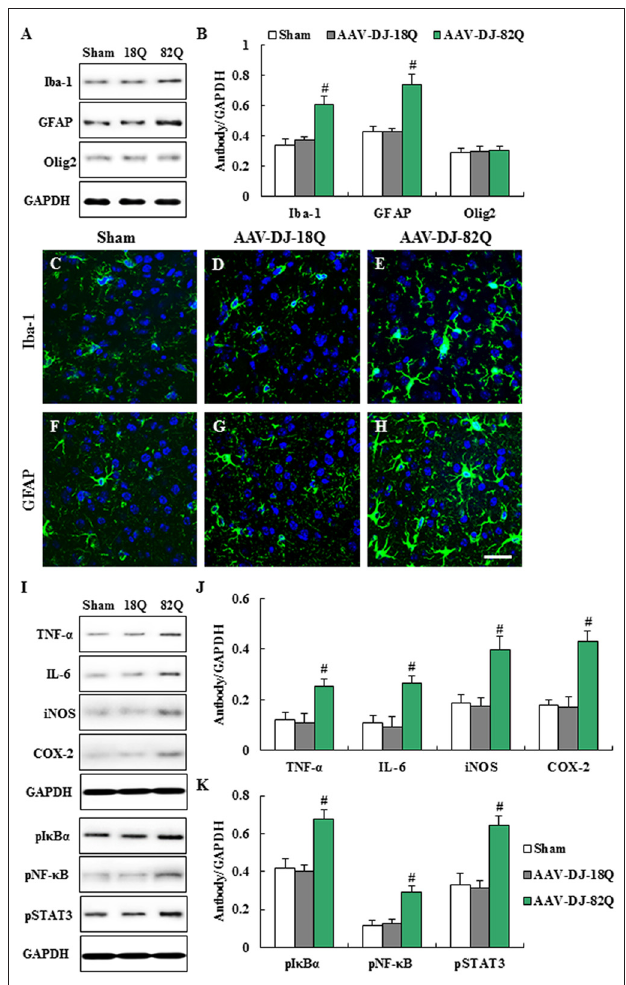
FIGURE 3 | AAV-DJ-82Q-infection induces microglial and astroglial activation and 263–270 inflammation in the striatum. (A–F) Eight weeks after the AAV-DJ-82Q-injection, the striata from sham, AAV-DJ-18Q, and AAV-DJ-/82Q groups ( n = 7 per group) were analyzed by Western blot to investigate change in protein expression of Iba-1, glial fibrillary acidic protein (GFAP), and Olig2 (A) and then quantified as the ratio of protein to total GAPDH for each sample (B) ANOVA test; # p < 0.05 vs. sham and AAV-DJ-18Q groups. (C–H) Striatal sections ( n = 2 per brain) from each group ( n = 7 per group) were accomplished by immunofluorescence stain using anti-Iba-1 (C–E) , and GFAP (F–H) antibodies. Scale bar denotes 100 µ m. (I–K) Eight weeks after AAV-DJ-82Q-injection, the striata from sham, AAV-DJ-18Q, and AAV-DJ-82Q groups ( n = 7 per group) were analyzed by Western blot to investigate change in protein expression of TNF- α , IL-6, iNOS, COX-2, p-I κ B α , p-NF- κ B, p-signal transducer and activator of transcription (STAT3) and GAPDH (I) and then quantified concerning the ratio of protein to total GAPDH for each sample (J,K) . (I) show a representative Western blot. ANOVA test; # p < 0.05 vs. sham and AAV-DJ-18Q